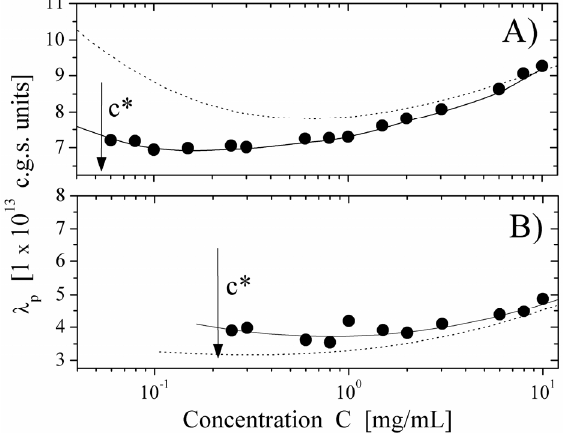
Figure 8. The equivalent conductance of 55% PMVP-Cl ( Q = 55%) polyion as a function of concentration C . Panel ( A ) polyion in water solution (poor-solvent condition). ( ): values derived from the measured electrical conductivity. Full line represents the corresponding values calculated according to the necklace model in the semidilute string-controlled condition, assuming τ = 0.6. The dotted line represents the calculated values in the semidilute good-solvent condition. Panel ( B ) polyion in ethylene glycol solvent (good-solvent condition). ( ): values derived from the measured electrical conductivity. Full line represents the corresponding values calculated according to the semidilute good-solvent condition. The dotted line represents the calculated values in the necklace model in semidilute-string-controlled condition. The arrow marks the concentration * c , indicating the transition between the dilute and the semidilute regime. Data from Reference